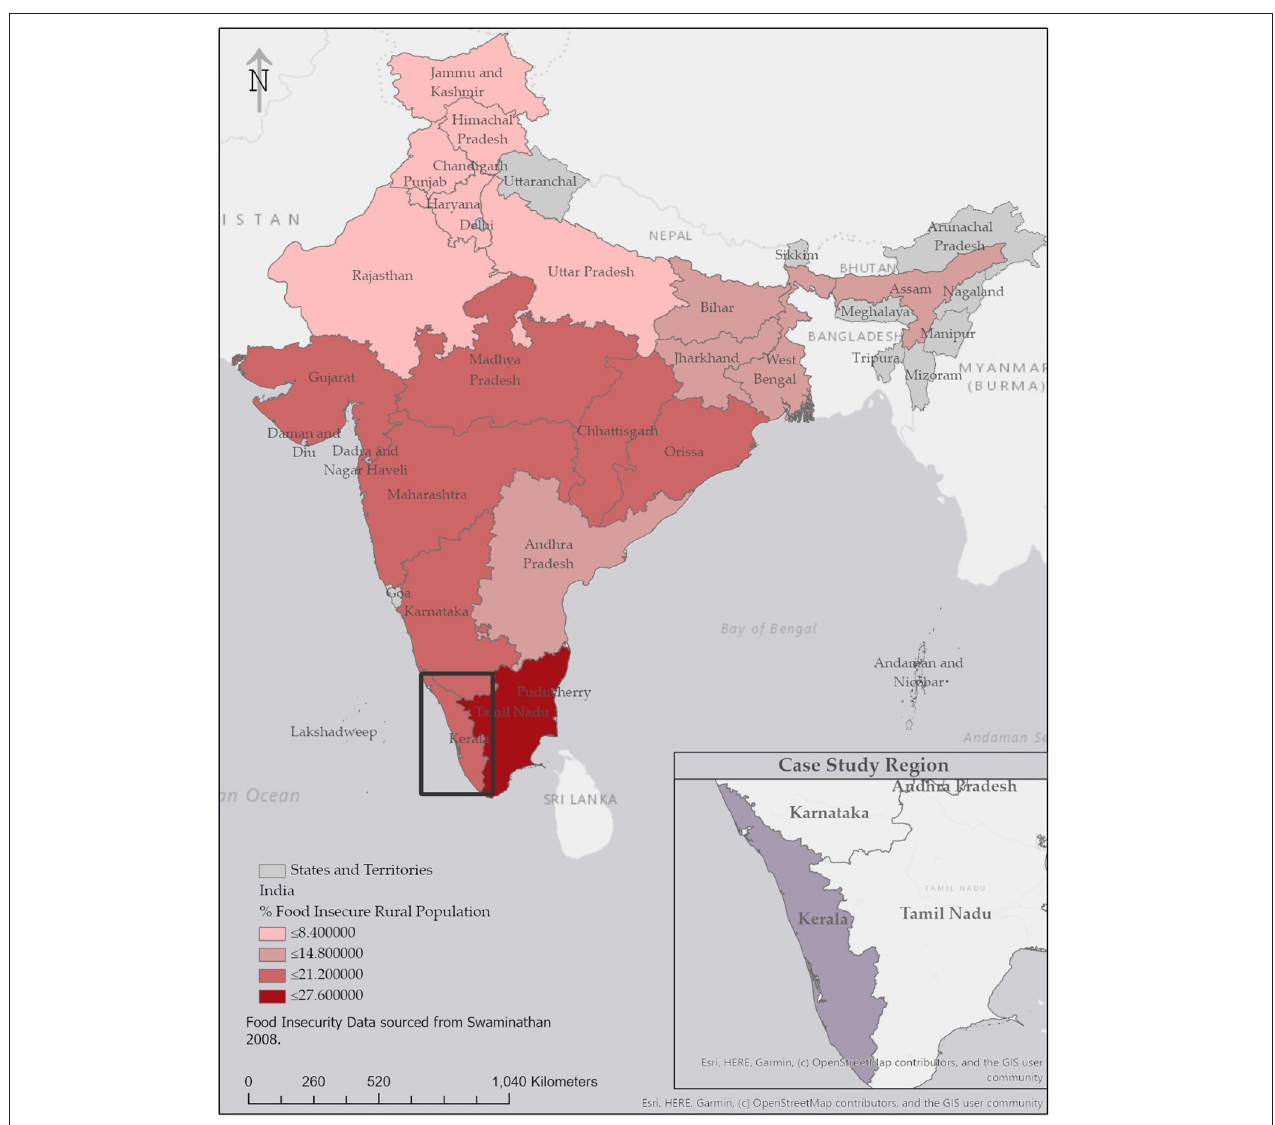
FIGURE 2 | Map of rural population in India consuming < 1,890 kilocalories per capita per